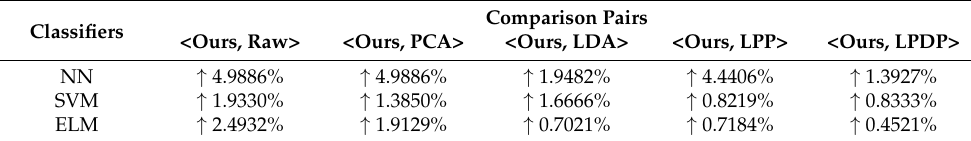
Table 9. Performance improvement between different pairs methods by using different classifiers.